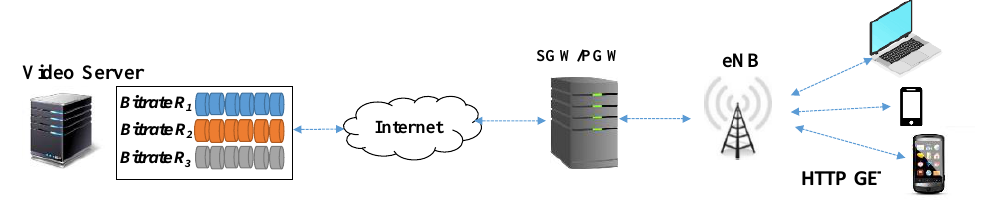
Figure 6. Network topology.